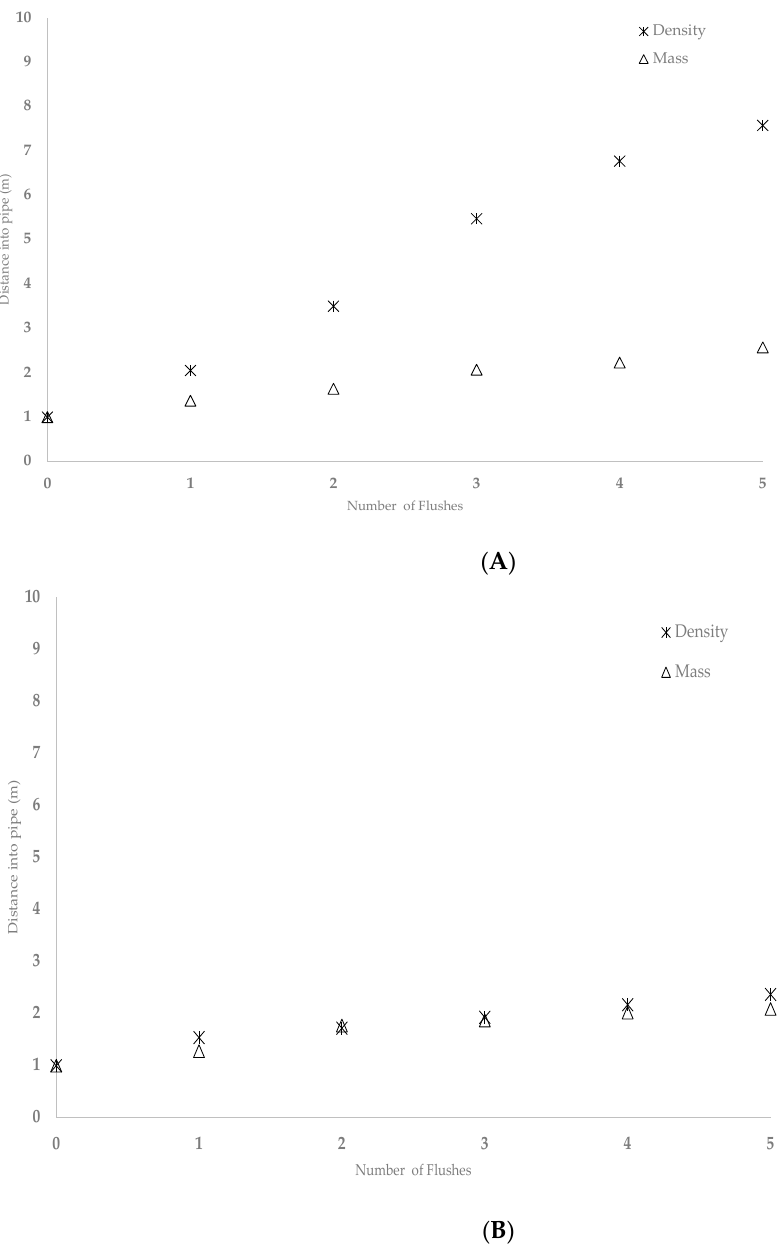
Figure 11. The effect of density on solid transportation. SG = 0.85 ( A ) and SG = 1.1 ( B ). Where the delta-SPH factor is incorporated into the continuity equation, Equation (6), as a means of reducing the fluctuation of density occurring in Lagrangian particle-based simulations, the results presented in Figure 10 show the effect that input- ting the solid density as opposed to solid mass has, particularly on the lighter solid as shown in Figure 11A. For both SGs the transportation distance is greater when the density has been input, where this is likely due to the density fluctuation. Referring to a solid of 0.85 specific gravity as shown in Figure 11A, after five flushes, the solid movement is significantly greater. As the solid is already less dense than water it will float in the water (whilst considering the limited effect of buoyancy due to the low water usage). As the density fluctuates, this will remain below the water density, and therefore will still be influenced by the buoyancy. In addition to buoyancy, the solid is impacted by external forces, including viscous drag. As the solid is lighter, it is further affected by the force from the fluid, where this instantly increases its distance in compar- ison to a heavier solid, whilst the impact of density on buoyancy and viscous drag will